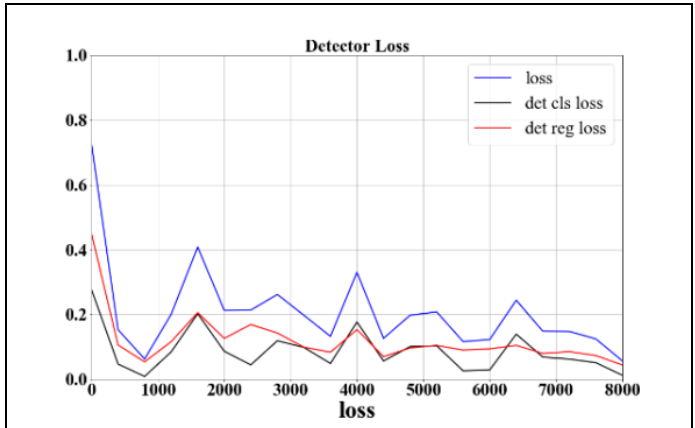
Figure 12. Loss function curve of RPN process.